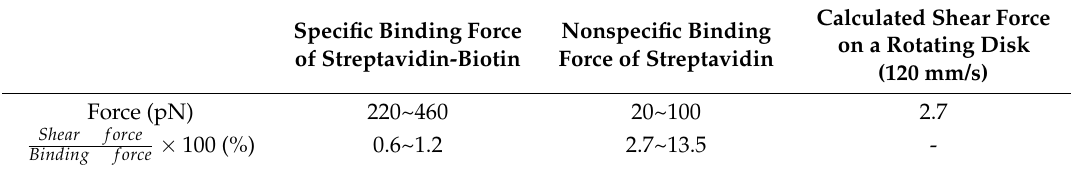
Table 1. Comparison of calculated shear force with specific and nonspecific binding